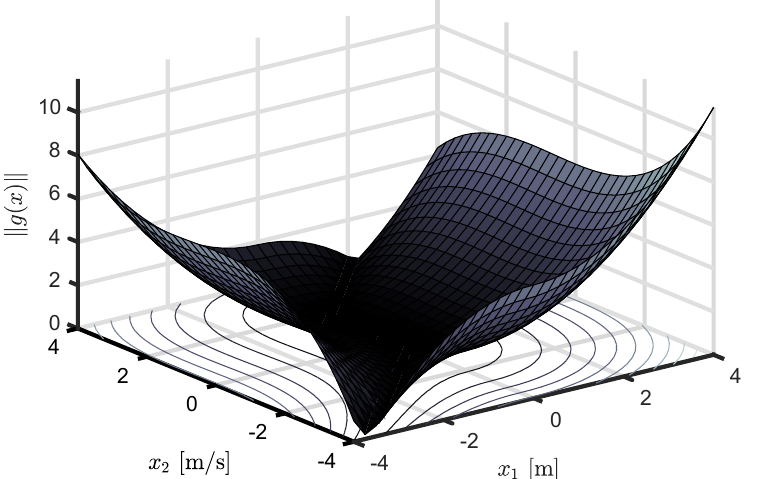
Figure 3. Indicative measure of the nonlinear behaviour associated with the point absorber system under study.